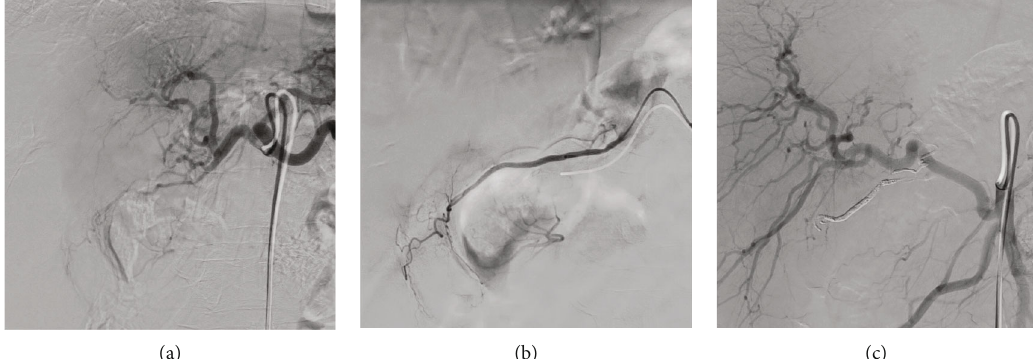
Figure 2: (a) Arteriography of the celiac trunk prior to embolization. (b) Selective arteriography of the gastroduodenal artery prior to embolization. (c) Arteriography after gastroduodenal artery embolization.